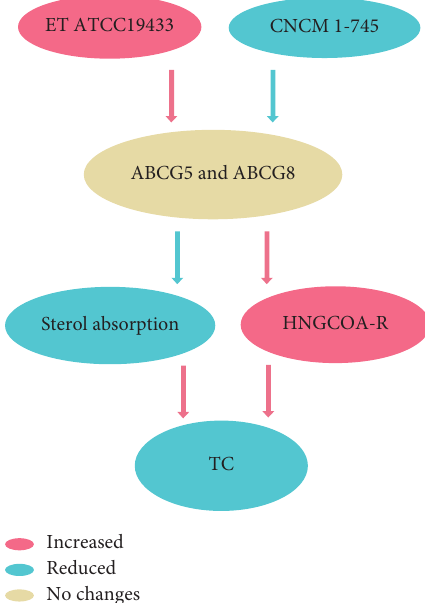
Figure 2: Different probiotics have the same effect on cholesterol through ABCG5 and